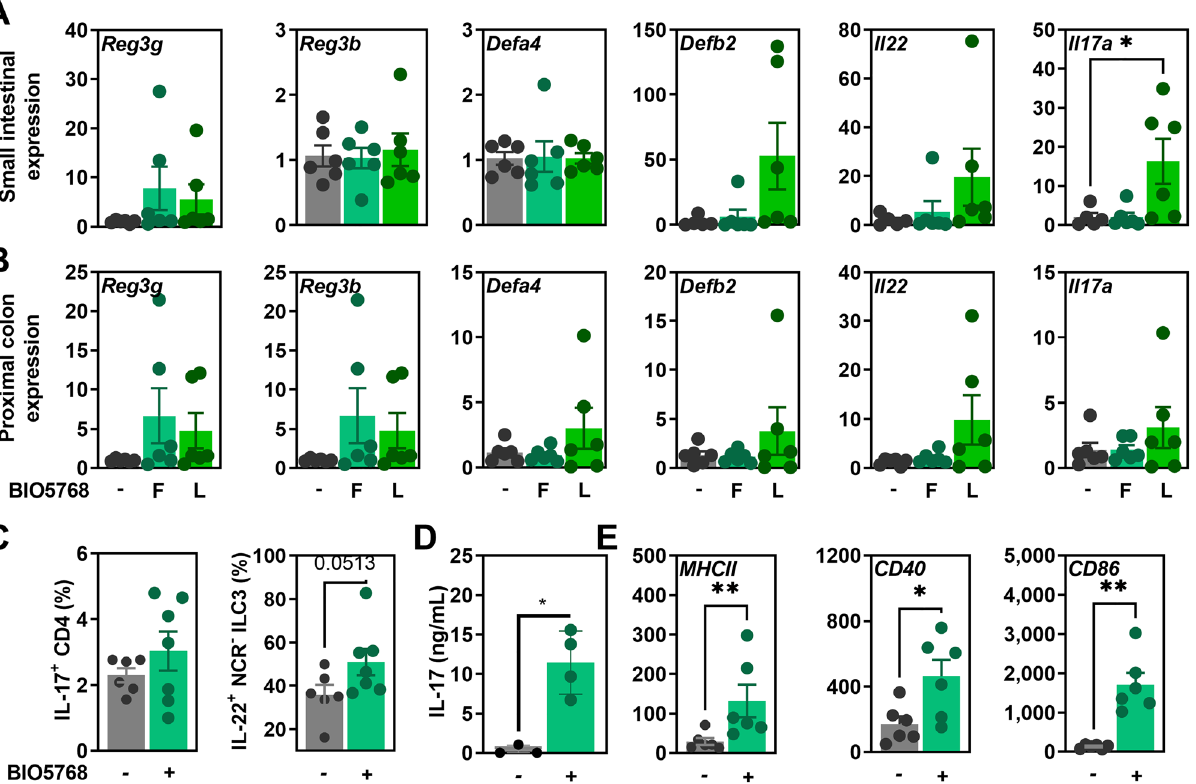
Figure 1. Capacity of the L. acidophilus BIO5768 to induce the expression of antimicrobial genes downstream of IL-17 and IL-22 and to activate bone marrow derived dendritic cells (BMDC) for supporting production of IL-17- and IL-22. Gene expression by qRT-PCR analysis of Reg3g, Reg3b , Defa4 , Defb2, Il22 and Il17a ( A ) in the small intestine or ( B ) in the proximal colon of BALB/c mice after 5 days of either fresh (F; n = 6) or lyophilized (L; n = 6) BIO5768 supplementation when compared to controls (n = 6). Results are expressed as relative gene expressions (2 −∆∆ct ) values, by comparing the PCR cycle thresholds (Ct) for the gene of interest and for the house keeping gene β-actin ( bact ), compared with control mice. ( C ) Percentage of IL-17-producing CD4 T cells and of IL-22 producing NCR- ILC3 within mesenteric lymph nodes of mice that were supplemented with BIO5768 (n = 7) when compared to control animals (n = 6), as determined by flow cytometry. ( D ) Measurement of IL17 production by ELISA in the supernatant collected after 24 h of coculture between untreated or BIO5768- stimulated BMDCs and naïve CD4 T cells that were sorted by magnetic beads. ( E ) Comparison of MFI (Mean of Fluorescence Intensity) of activation markers MHCII, CD40 and CD86 in untreated or BIO5768-stimulated BMDCs. Representative results of 6 independent in vitro experiments are shown (bars represent mean ± SEM). * p < 0.05; **p < 0.01; ***p <